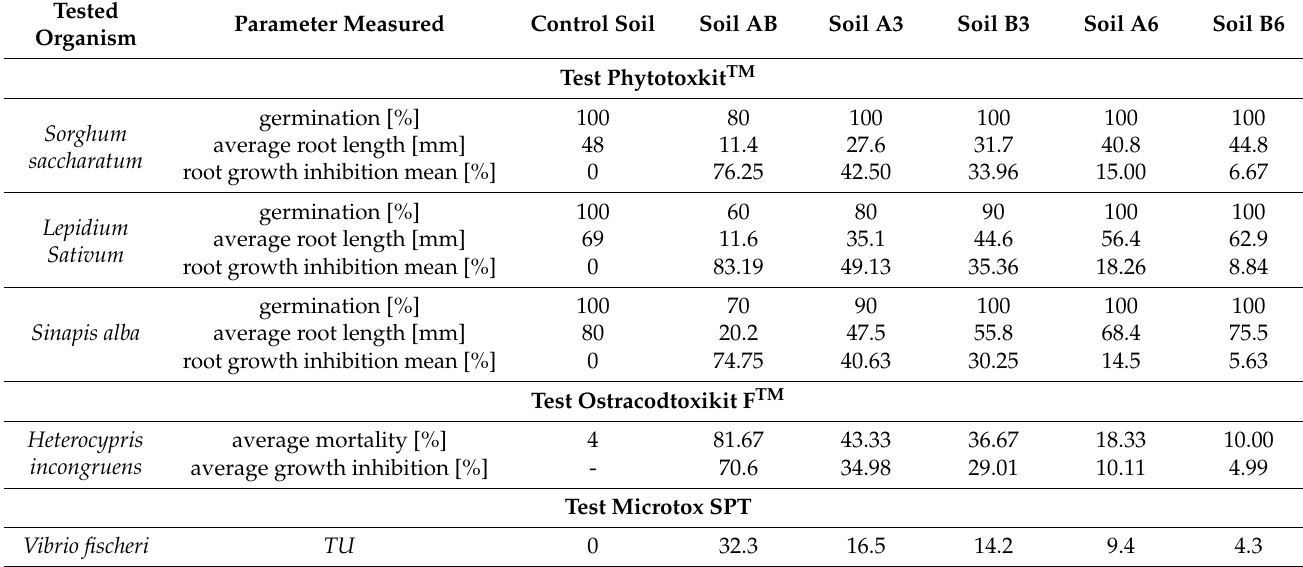
Table 5. The results of Phytotoxkit TM , Ostracodtoxikit F TM and Microtox SPT toxicology